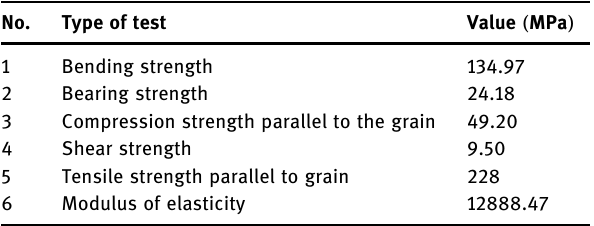
Table 1: The mechanical properties of apus bamboo [ 18